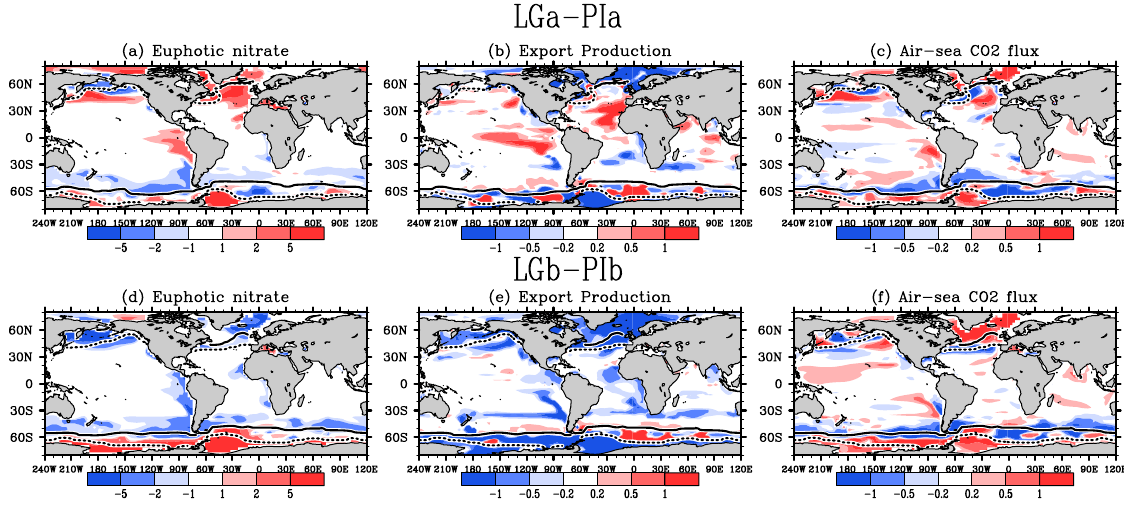
Fig. 8. Annual-mean euphotic averaged nitrate anomaly (mmolm − 3 ), export POC anomaly (molCm − 2 yr − 1 ), and air-sea CO 2 flux anomaly (molm − 2 yr − 1 ) (a – c) between LGa and PIa and (d – f) between LGb and PIb. Solid (dotted) lines refer to glacial sea ice fraction of 0.1 in August (February).